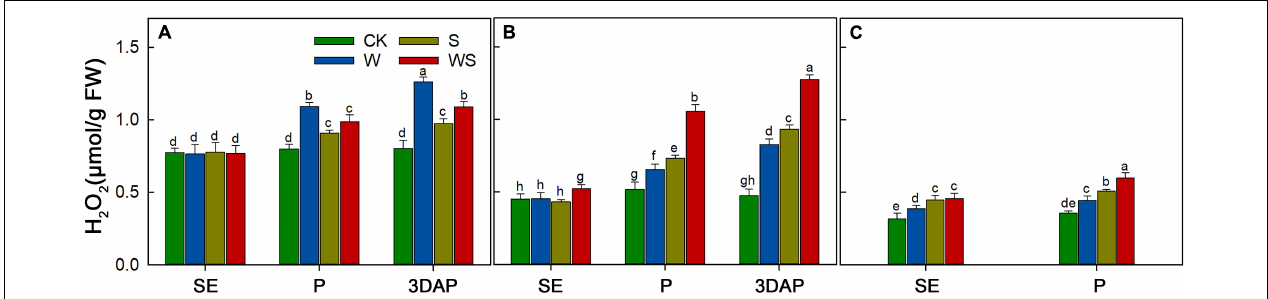
FIGURE 9 | H 2 O 2 contents in leaf (A) , ovary (B) , and silks (C) at SE (first silk emergence), P (full silk emergence), and 3DAP (3 days after pollination) in control (CK), waterlogging + shading (WS), waterlogging (W), and shading (S) treatment groups. Data were subjected to one-way ANOVA followed by Duncan’s new multiple range test ( n = 3). Different letters above bars indicate significant differences ( P < 0.05). Error bars represent ±